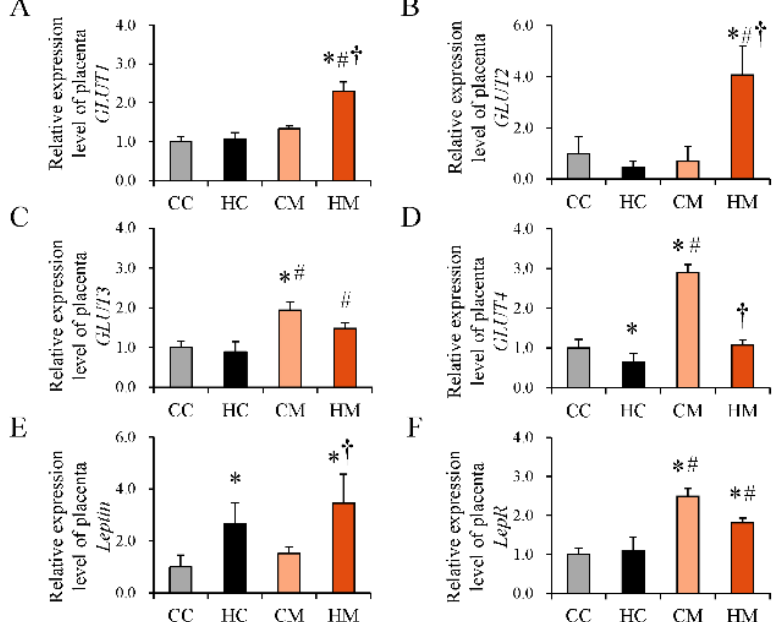
Figure 2. Histological features of placenta with maternal high-fat diet and metformin therapy. ( A ) Histological exhibition of the placenta. The average thicknesses of the basal decidua, junctional zone, and labyrinth zone are illustrated. Magnification at 10 × ( B ) Oxidative stress was determined by 8-hydroxy-2-deoxyguanosine (8-OHdG) staining. Magnification at 40 × * Compared to the CC group, p < 0.05; # compared to the HC group, p < 0.05; † compared to the CM group, p < 0.05. CC, maternal control diet group; HC, maternal high-fat diet group; CM, maternal control diet with metformin treatment after mating; HM, maternal high-fat diet with metformin treatment after mating; IOD, image optical density.